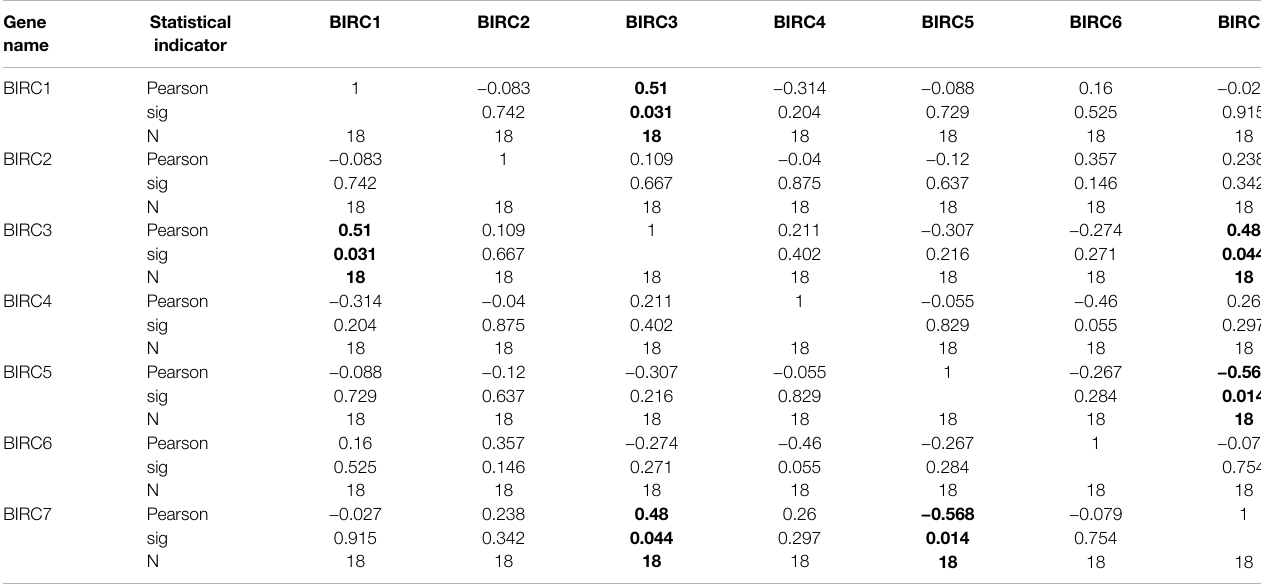
Bold values indicate p <